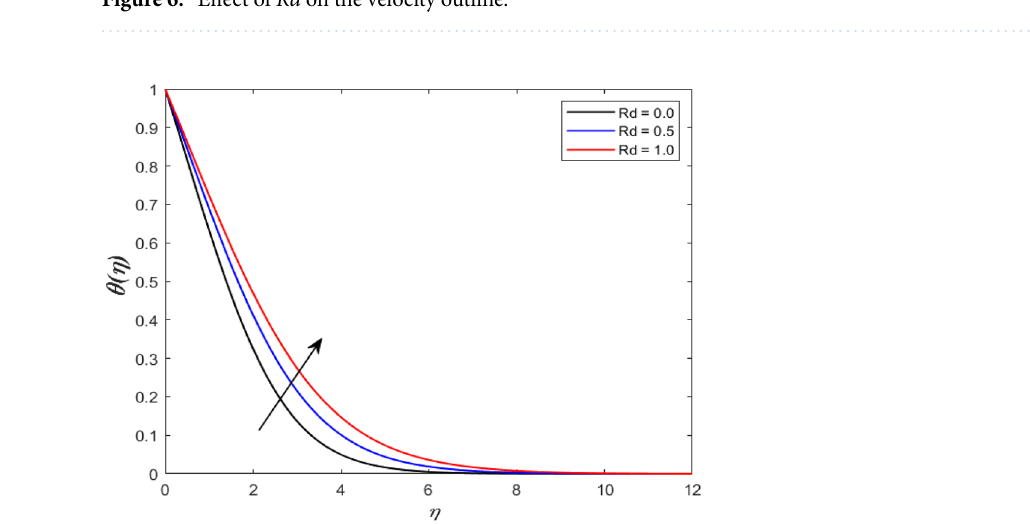
Figure 6. Effect of Rd on the velocity outline.